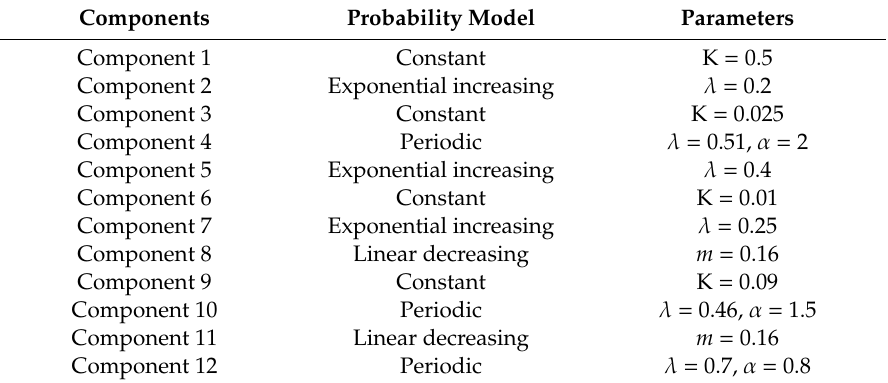
Table 3. Unreliability models.